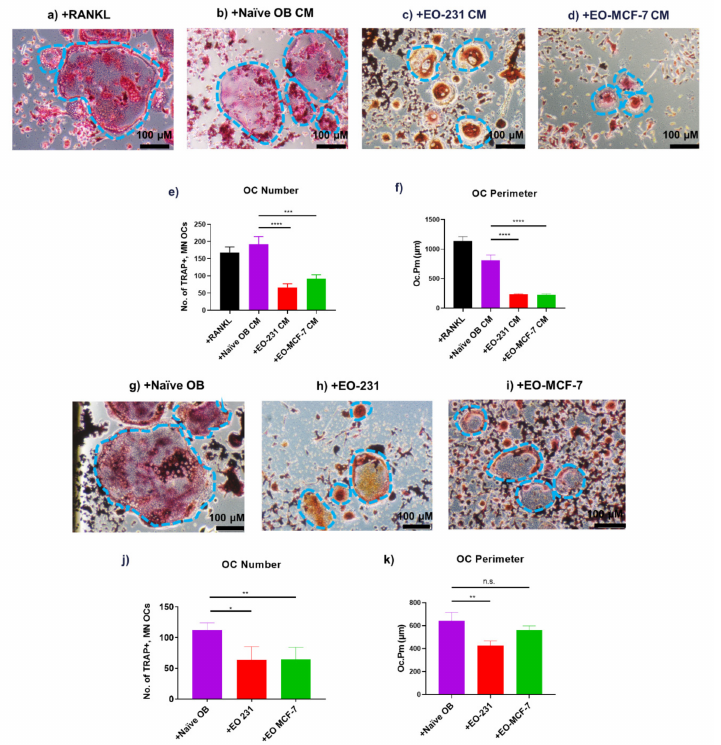
Figure 2. Osteoclasts Produced in the Presence of EO CM or EO Cells are Smaller and Less in Number. RAW 264.7 pre-osteoclasts were culture in the presence of ( a ) 50 ng/mL exogenous RANKL for six days (control) or exposed to the following conditions in the presence of 50 ng/mL exogenous RANKL: ( b ) naïve OB CM (control), ( c ) EO-231 CM, or ( d ) EO-MCF-7 CM. The number (No.) of TRAP+, multinucleated ( ≥ 3 nuclei) mature osteoclasts (pink/red/purple color; blue outlines) and osteoclast perimeter (Oc.Pm) were quantified for each CM condition ( e,f ). In a separate experiment, RAW264.7 cells were co-cultured in the presence of 50 ng/mL exogenous RANKL for six days with ( g ) naïve osteoblasts (control), ( h ) EO-231, or ( i ) EO-MCF-7 cells. Cultures were stained for tartrate-resistant acid phosphatase (TRAP), a common maker for mature osteoclasts. The number (No.) of TRAP+, multinucleated mature osteoclasts (pink/red/purple color; blue outlines), and osteoclast perimeter (Oc.Pm) were quantified for co-culture conditions ( j , k ). Scale = 100 µ M. N = 3. * p < 0.05; ** p < 0.01; *** p < 0.001, **** p < 0.0001; n.s. = not